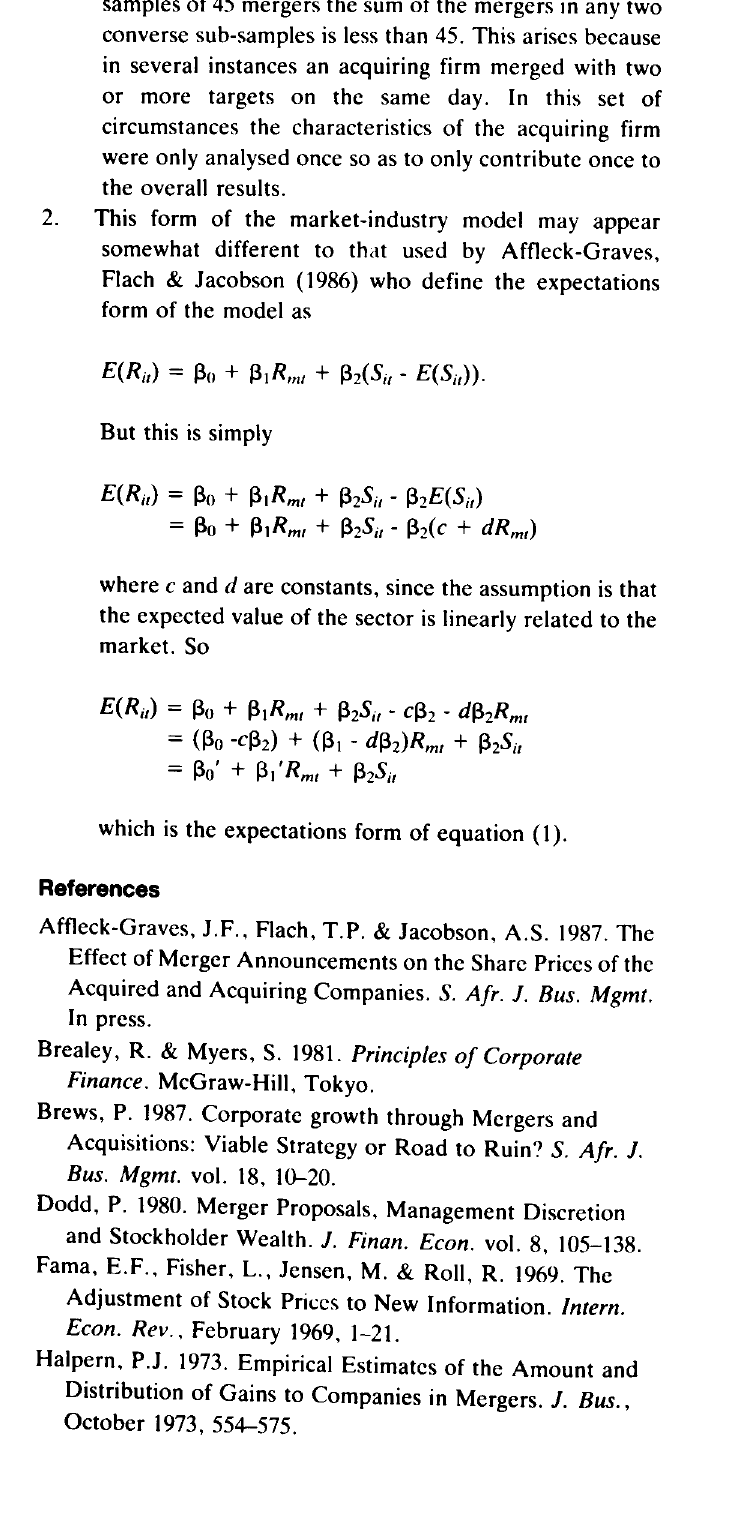
Figure 16 CAAR plot for target firms in cash exchange mergers (sample